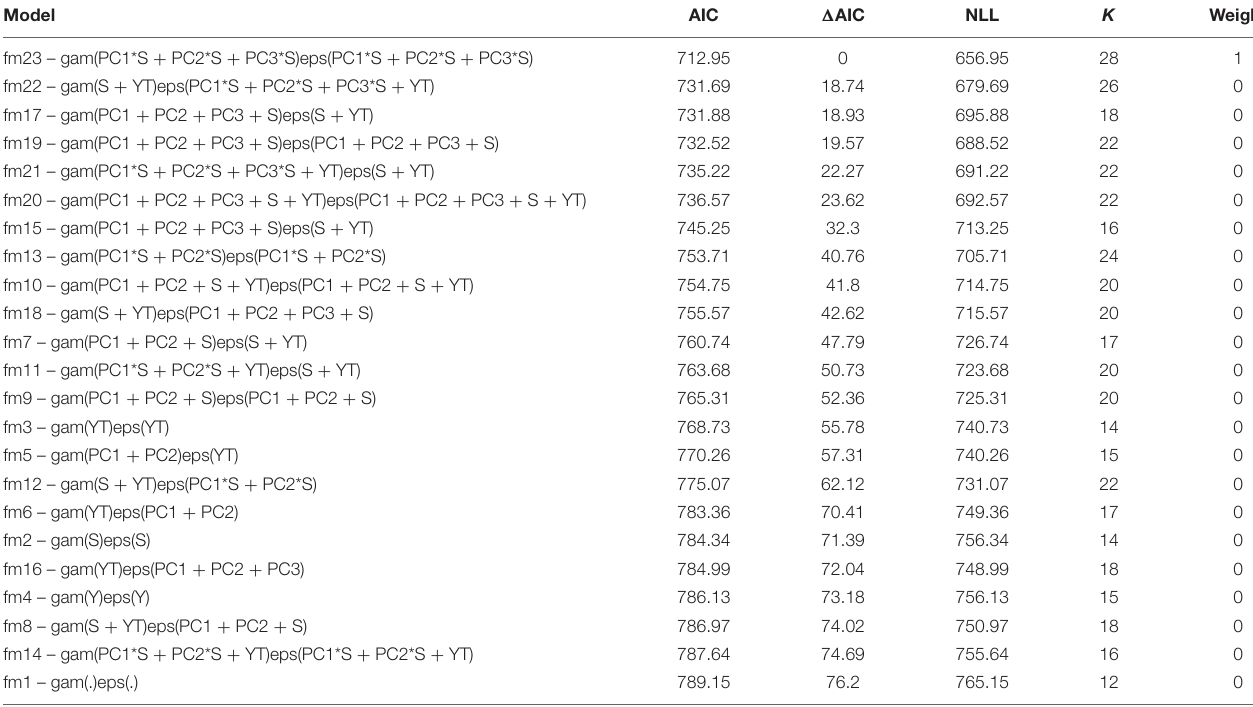
Model names indicate structure for colonization(gam) and extinction(eps). Structure for occupancy and detection was “psi(PC1 + PC2 + PC3)” and “p(PC1 + PC2 + northing + slope + season).” In model names, “S” is season, “Y” is year, and “YT” is year-trend. “ (cid:49) AIC” is the delta AIC score, “NLL” is -2 ∗ loglikelihood, “K” is the number of parameters, and “Weight” is the model